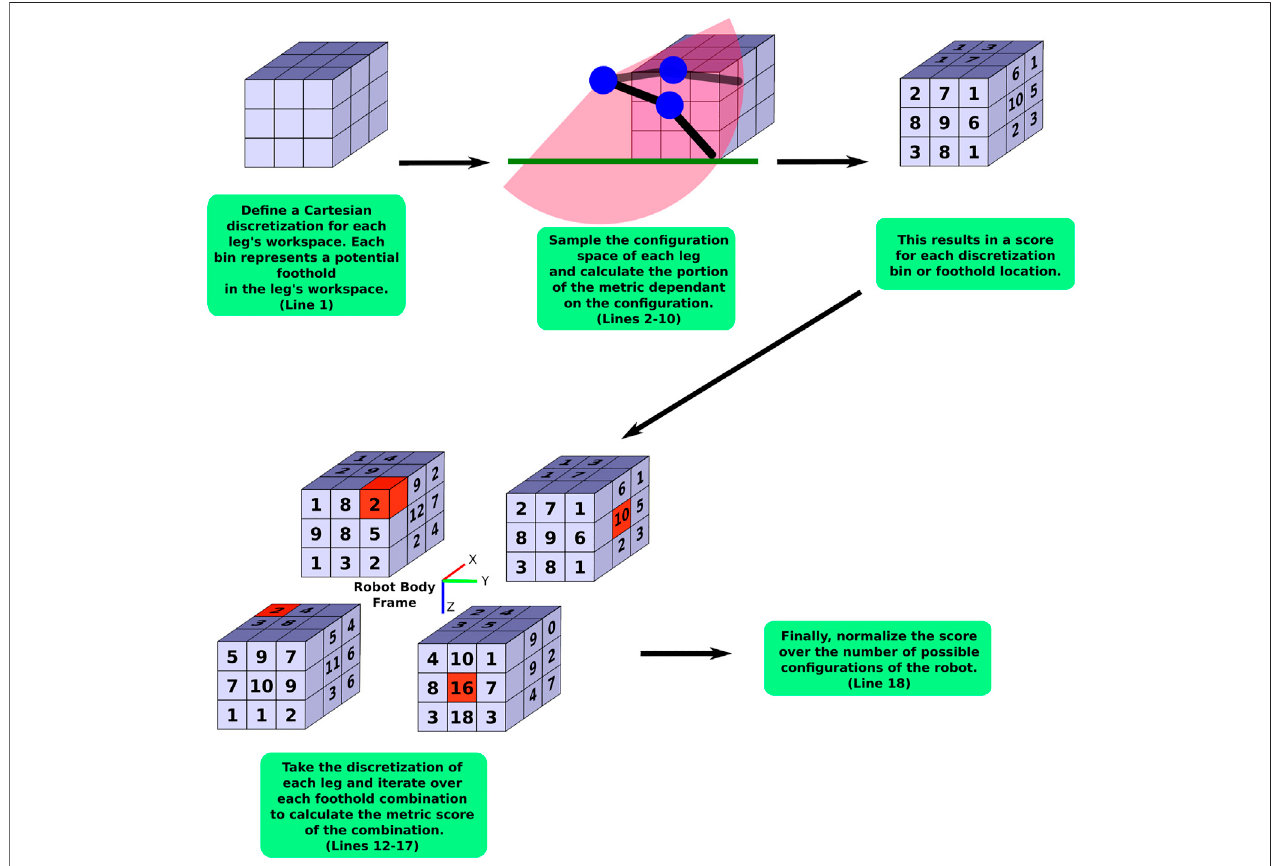
FIGURE 3 | A fl ow chart visualizing the general approximation method as outlined in detail in Algorithm 1. The red cubes indicate an example of a foothold combination.